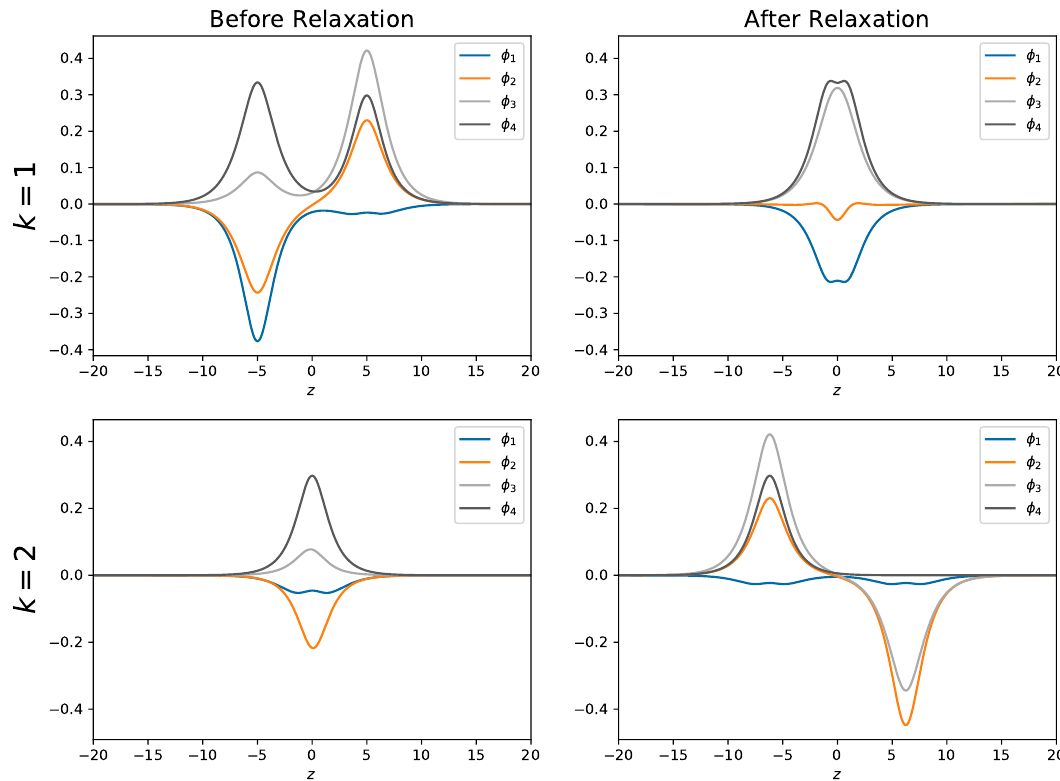
Figure 18. Attraction and repulsion of DWs for N = 5 and k = 1 , 2 . The initial conditions, of which the φ fields are depicted in the left column, consist of the sum of two BPS 1-walls similar to those depicted in figure 16. These initial conditions were relaxed for up to 100,000 iterations of the relaxation algorithm, with the usual error tolerance of 10 − 9 . The φ fields for these solutions are depicted in the right column. In the top row, an N -ality k = 1 configuration of two DWs separated by 10 units is seen to attract to form a single string. The resultant φ field is comparable with — but not identical to — the sum of the φ fields of the individual 1-walls, having a smaller magnitude and an additional central divot as compared to the summed field (compare with the lower-left panel of figure 16). Although not depicted here, the σ field of the relaxed solution appears as the sum of the σ fields of the individual 1-walls, as depicted in the lower-right panel of figure 16. In the bottom row, an N -ality k = 2 configuration with an initial separation of 0 is seen to repel to form a double string. In this case, the resultant φ and σ fields both appear as the simple sum of the individual 1-walls, reminiscent of the top row of figure